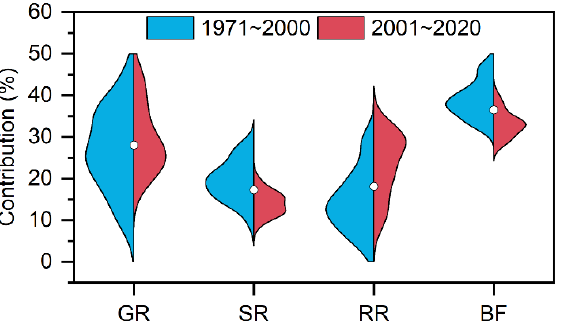
Figure 13. Comparison of contributions of runoff components to total runoff before and after the abrupt change of the total runoff.